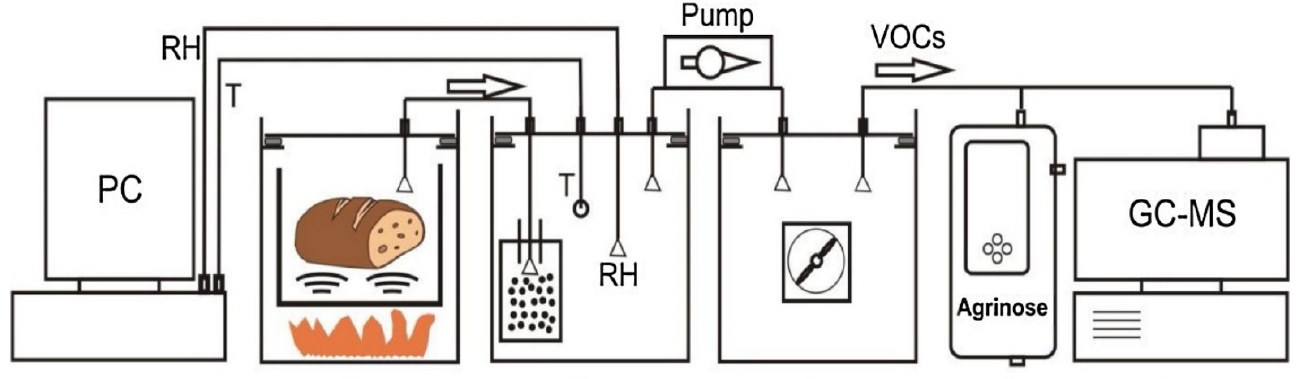
Figure 4. Schematic diagram of E-nose system combined with GC-MS for monitoring VOC emissions during the bread production process. (Reproduced with permission from Elsevier [137].)